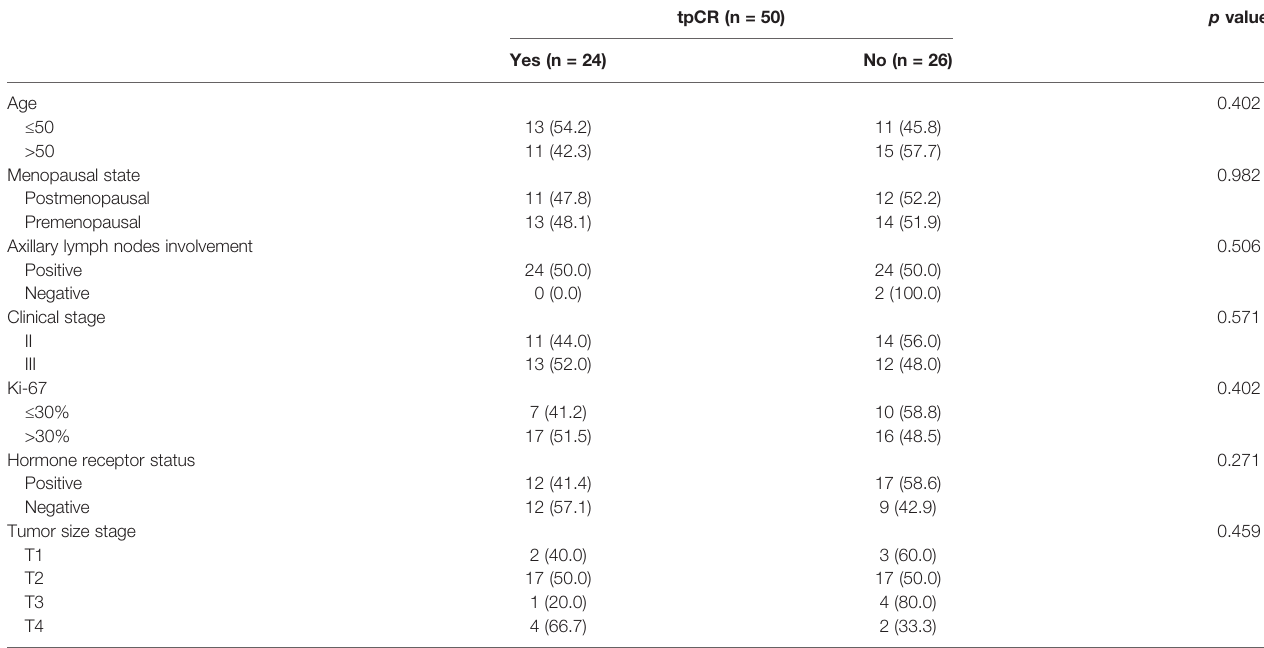
TABLE 2 | The effect of clinical characteristic variables on the